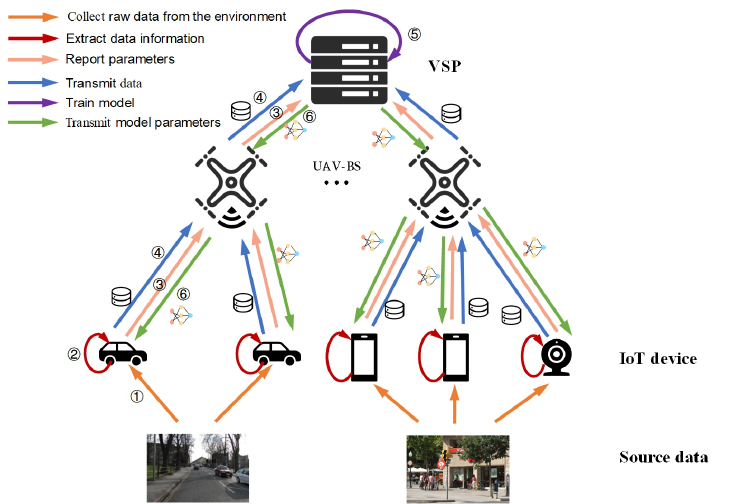
Figure 2. Constructing metaverse digital twin by receiving data from multiple